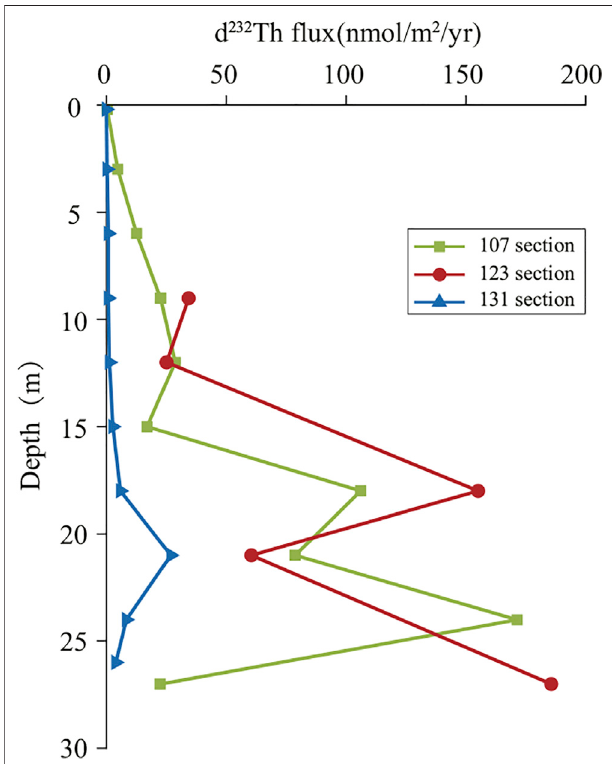
FIGURE 5 | Distribution characteristics of dissolved 232 Th fl ux in the depth pro fi les of Qinghai Lake.